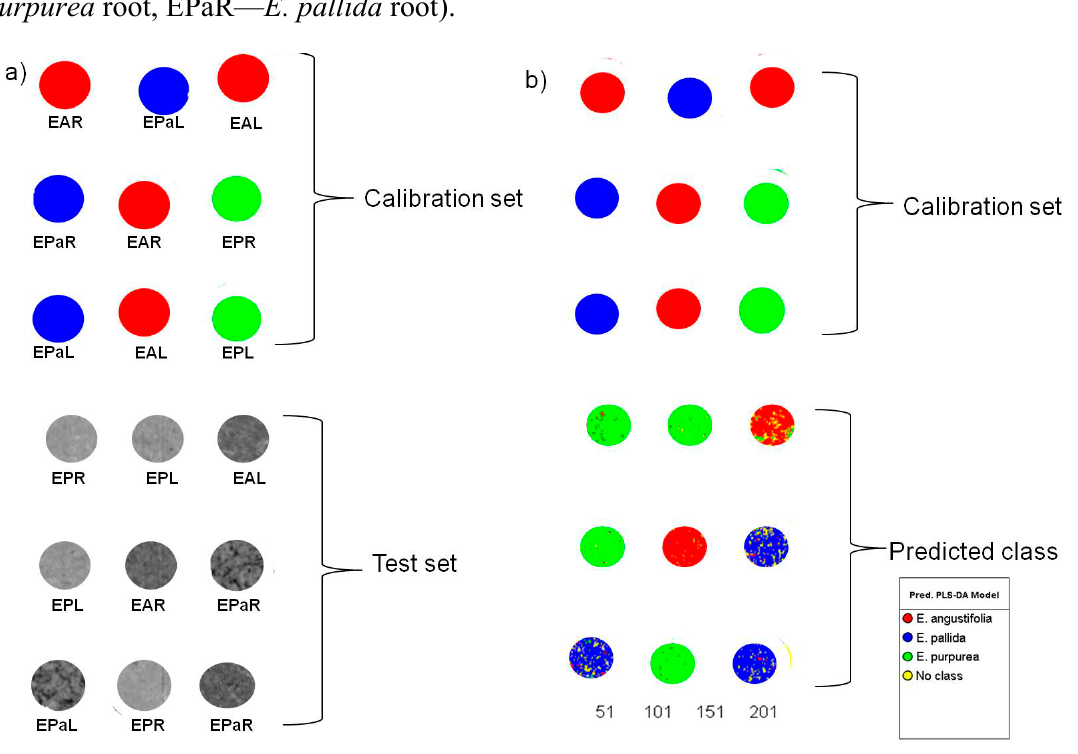
Figure 8. PLS-DA Y-image showing calibration samples used to build the model and test samples that were excluded for model validation ( a ). The predictions show test samples assigned to classes that correspond to the species imaged ( b ) (EAL— E. angustifolia